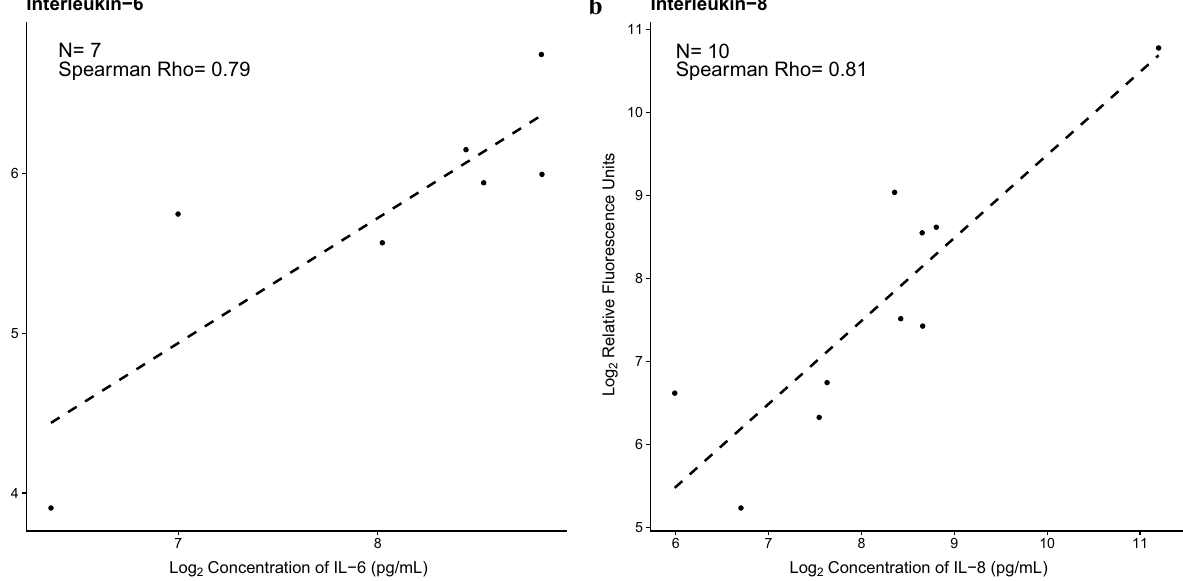
Figure 3. Correlation between SOMAscan assay and the corresponding ELISA assay for differentially abundant proteins. The figure shows the scatter plots (created in R 115 ) of log 2 transformed relative fluorescence units determined with SOMAscan assay on the y- axis and log 2 transformed ELISA concentrations (pg/ml) on the x-axis for ( a ) interleukin (IL)-6, and ( b ) IL-8. Spearman’s correlation coefficients are also shown.